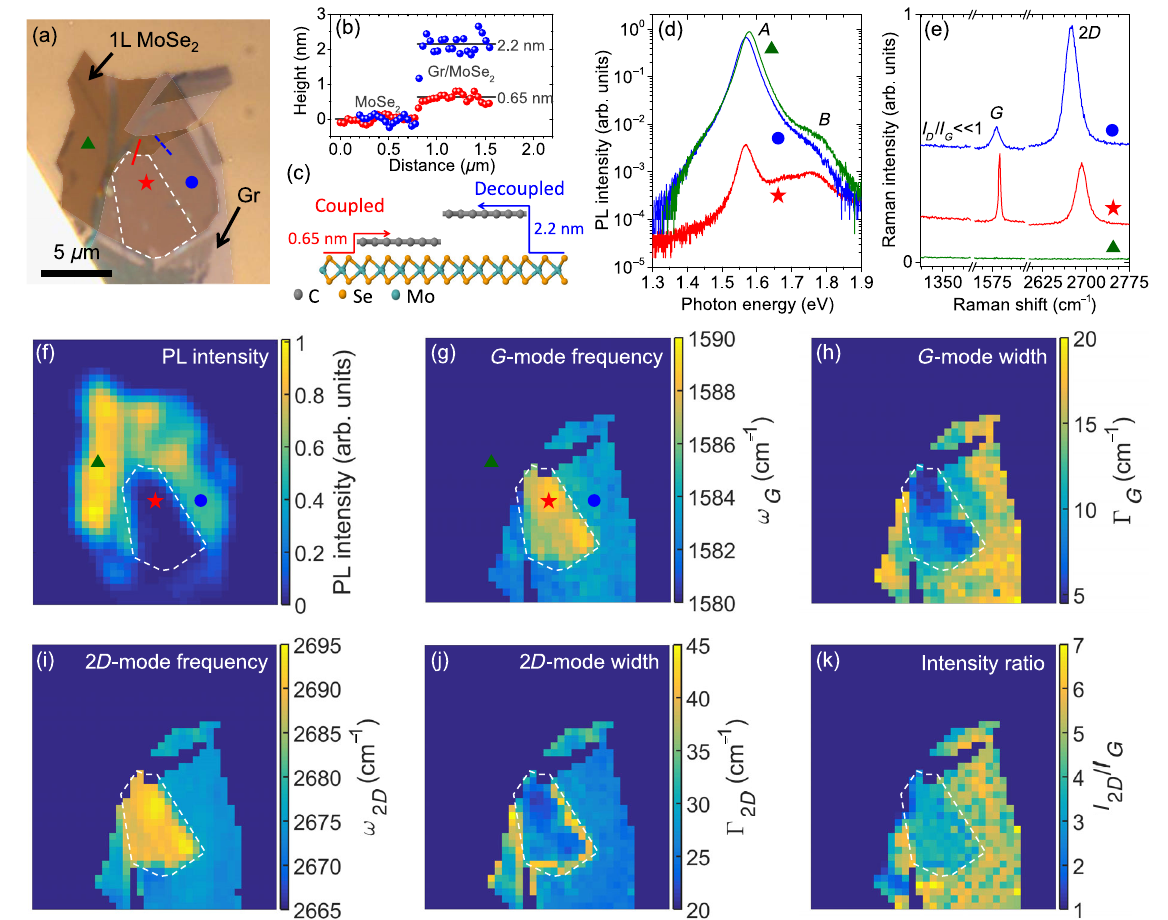
FIG. 1. (a) Optical image of a single-layer graphene/single-layer MoSe 2 van der Waals heterostructure deposited onto a Si = SiO 2 substrate (sample S 1 ). The coupled part of the heterostructure is represented by the white dashed contour. (b) Height profiles, measured by atomic force microscopy, along the dashed blue and red lines drawn in panel (a). (c) Schematic of the heterostructure showing the coupled and decoupled regions. Photoluminescence (d) and Raman scattering (e) spectra recorded on the three spots shown in panels (f) and (g), respectively. In panels (d) and (e), the spectra are plotted with the same color as the symbols in panels (f) and (g), respectively. (f) MoSe 2 photoluminescence intensity map. (g) – (k) Hyperspectral Raman maps of the (g) G -mode frequency ω G , (h) G -mode FWHM Γ D -mode frequency ω 2 D -mode FWHM Γ D - and G -mode G , (i) 2 2 D , (j) 2 D , and (k) ratio between the integrated intensities of the 2 features ( I 2 D =I G ) measured on single-layer graphene. All maps have the same scale as in panel (a) and were recorded in ambient air at ¼ 2 × 10 19 cm − 2 s − 1 and Φ ¼ 2 × 10 22 cm − 2 s − 1 for photo- a laser photon energy of 2.33 eV, with an incident photon flux Φ ph ph luminescence and Raman measurements,